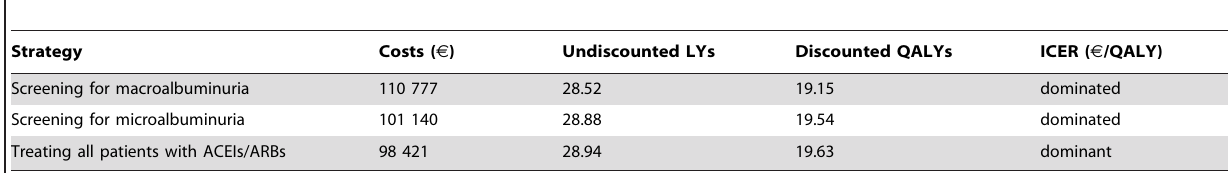
Table 3. Results of the base-case analysis, based on mean estimates of input variables.